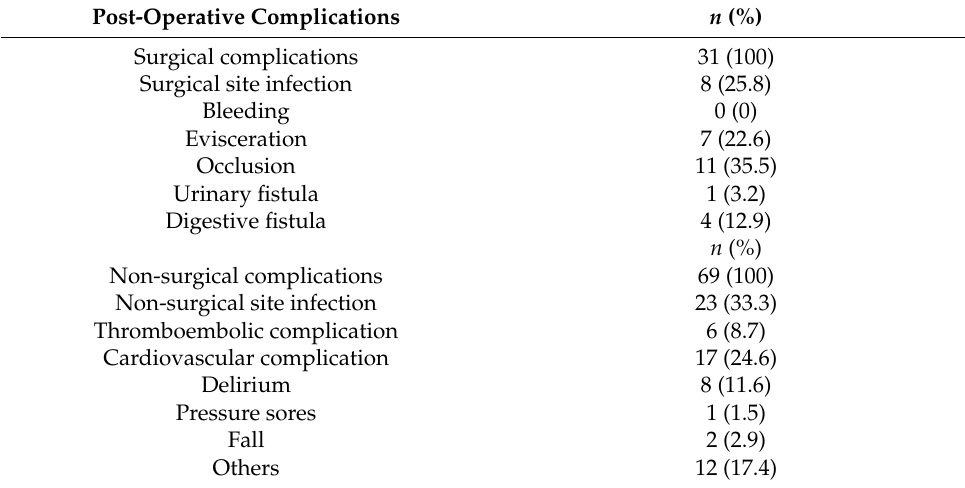
Table 2. Post-operative